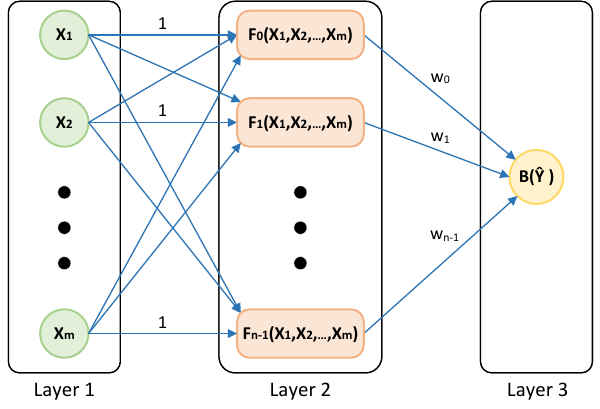
Figure 1. Structure of the WASDMC-based neural